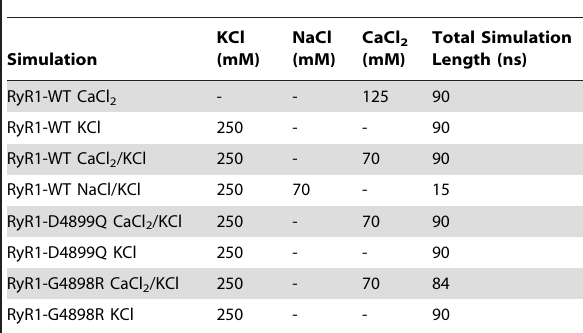
Table 1. Concentrations of ions used in different simulations.